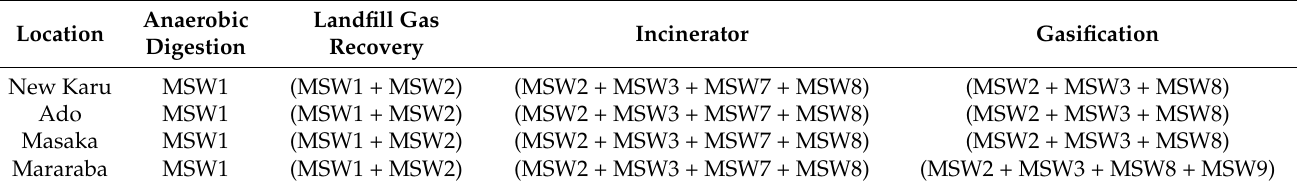
Table 3. Waste classification according to the applicable energy recovery